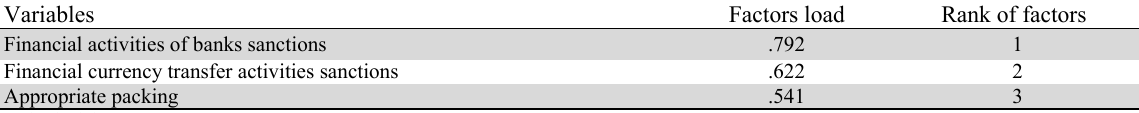
The summary of customer orientation factors influencing on creativity Variables